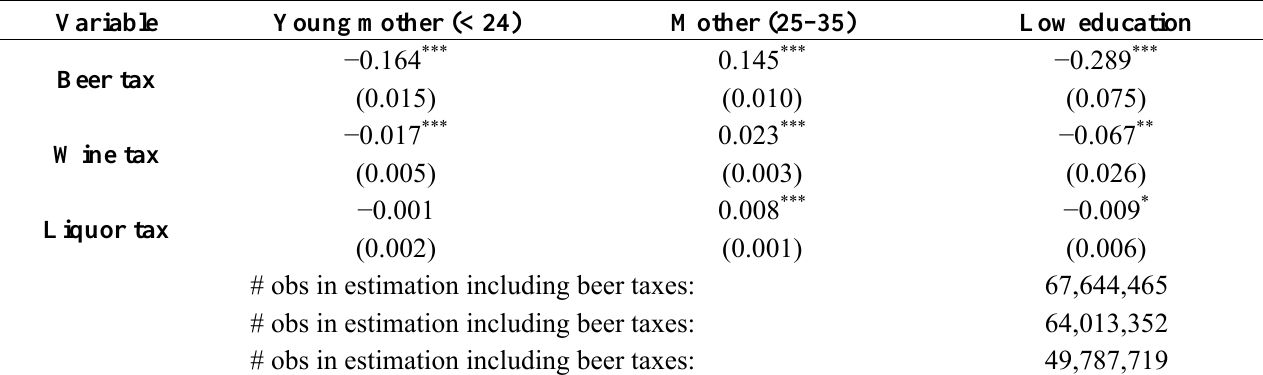
Table 3. Composition of Mothers (Natality